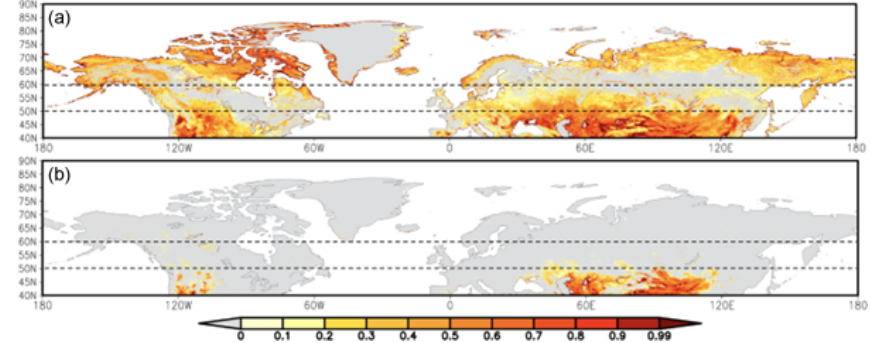
Figure 2. UNCCD Global Sand and Dust Storms Source Base Map (G-SDS-SBM) for annual maximum (a) and minimum (b) SI for the northern HLD region and Arctic subregion (north of 50 and 60 ◦ N, respectively, marked with dashed lines).